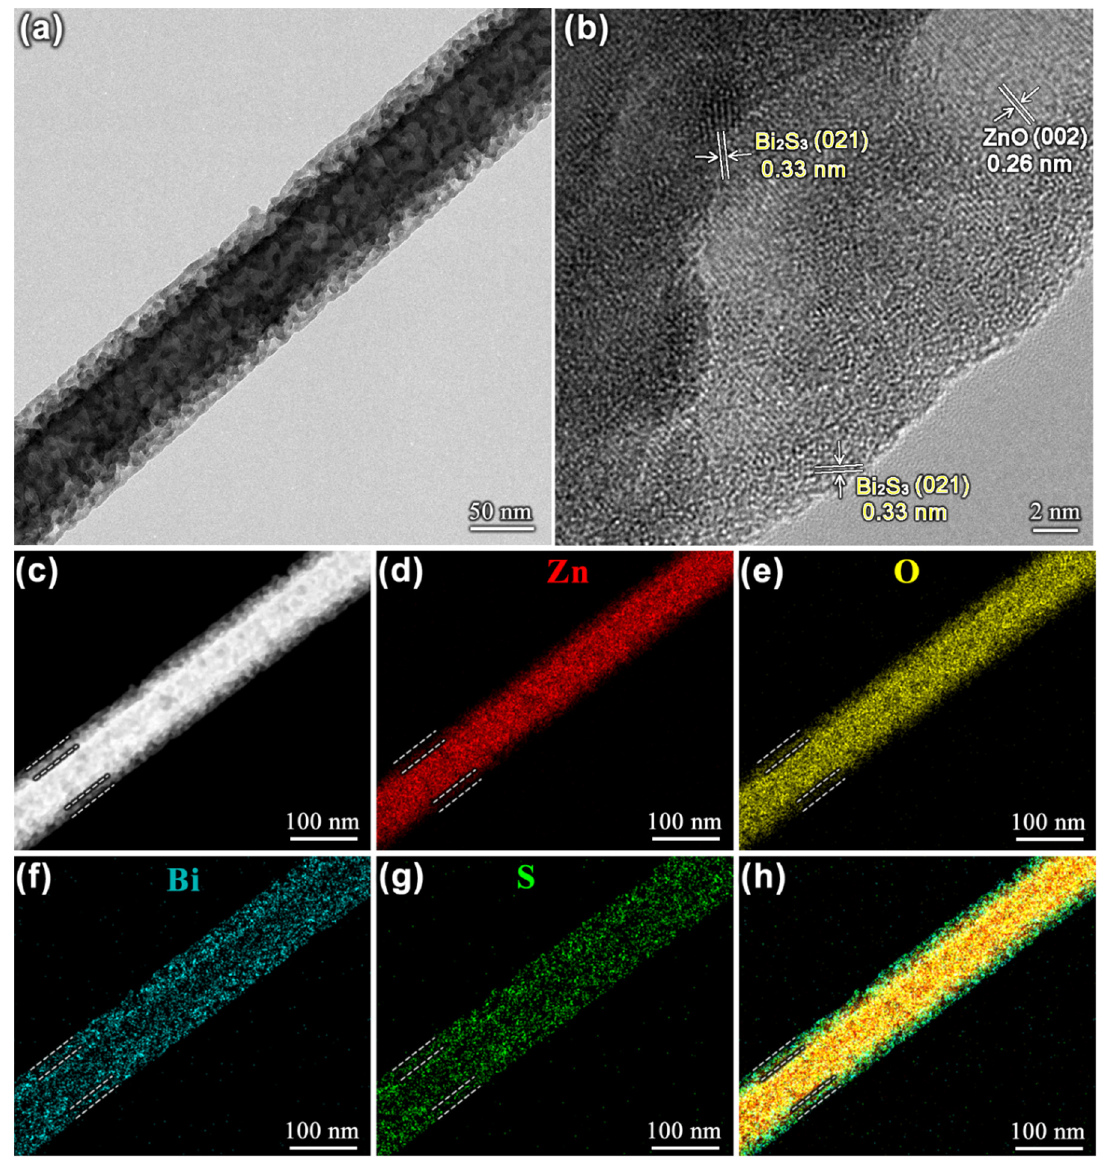
Figure 3. The ZnO/Bi 2 S 3 photoanode: ( a ) TEM, ( b ) HRTEM, ( c ) STEM images, and the corresponding EDAX elemental mappings of ( d ) Zn, ( e ) O, ( f ) Bi, ( g ) S, and ( h ) the merged image of Zn, O, Bi, and S elements.